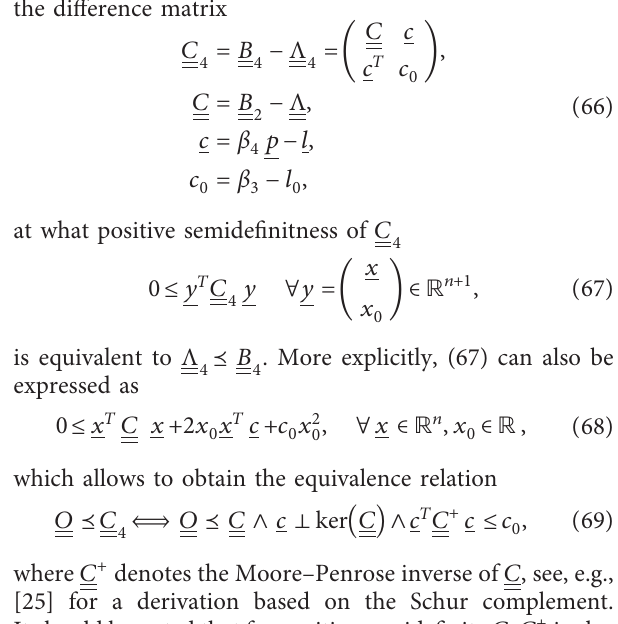
, the 2 , and the gray 2